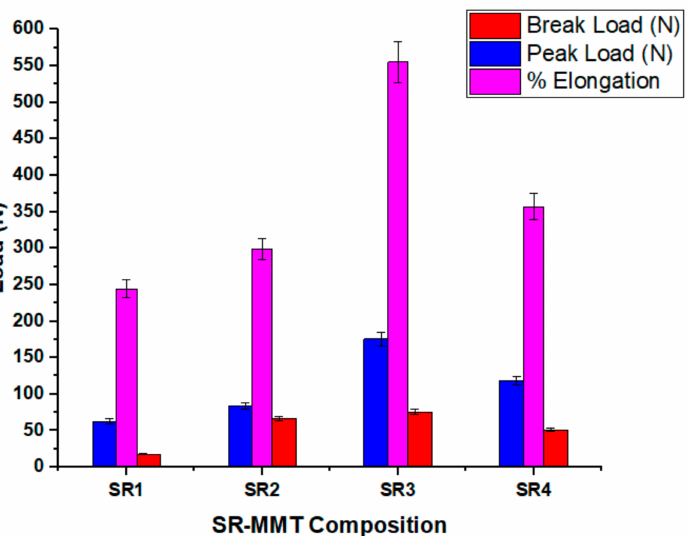
Figure 6. Variation of peak load, break load and % elongation at break for SR–MMT